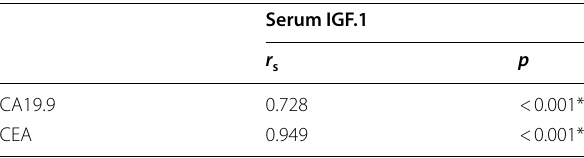
Table 5 Correlation between IGF rs6214 with CA19.9 and CEA in colorectal cancer group ( n